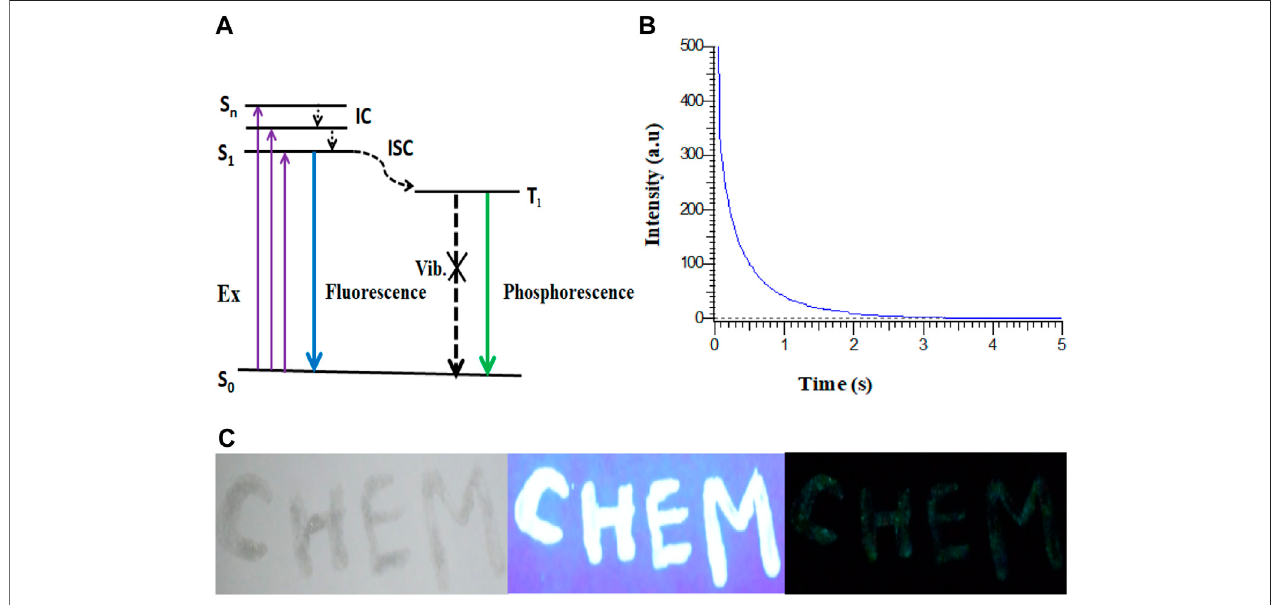
FIGURE 6 | (A) Probable mechanism of RTP in Cl-CNDs. (B) Phosphorescence lifetime decay pro fi le of Cl-CNDs under 360 nm excitation wavelength and emission monitored at 490 nm. (C) Application of Cl-CNDs as a phosphorescent ink for anti-counterfeiting (from left to right under daylight, 365 nm UV light on and off).